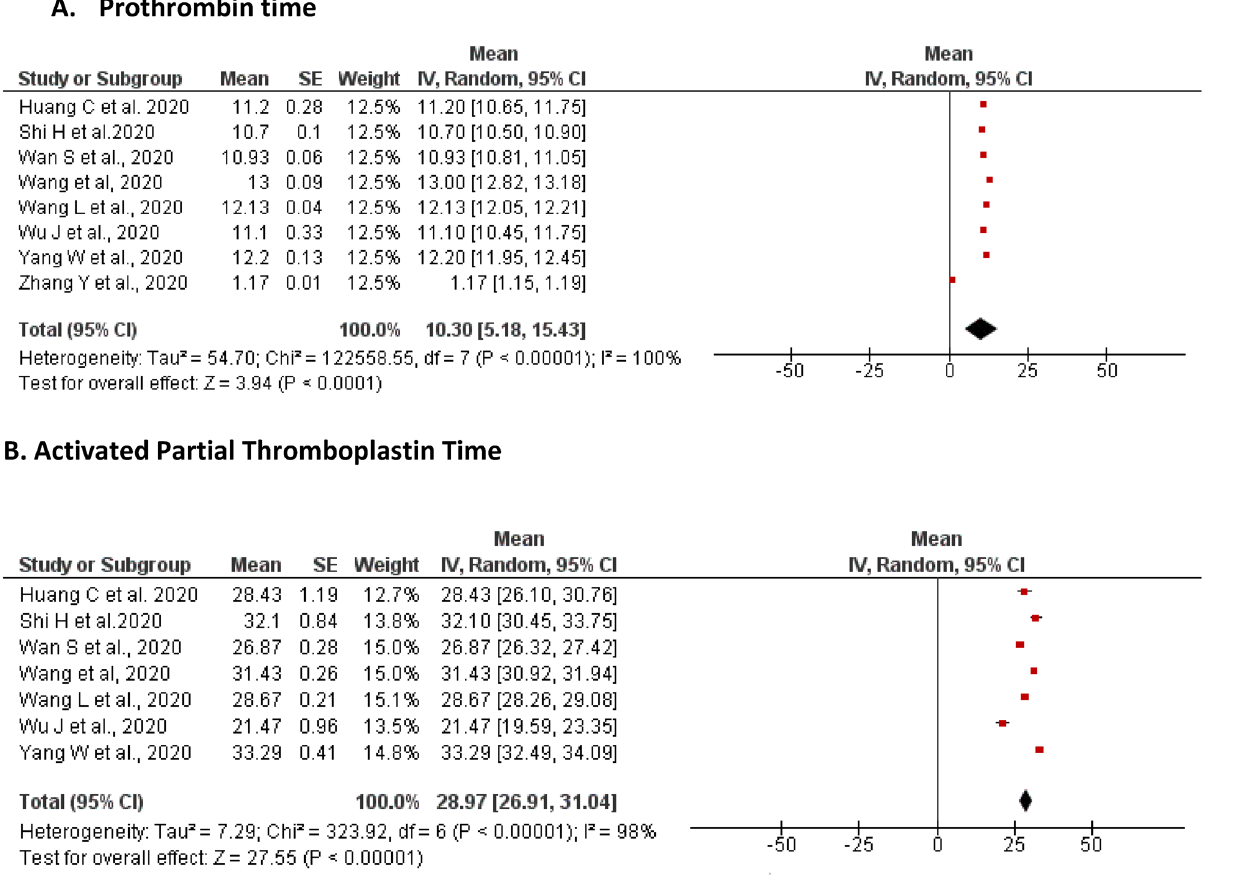
Figure 3. Meta-analyses of the pooled mean of coagulation parameters. ( A ) prothrombin time; ( B ) Activated Partial Thromboplastin